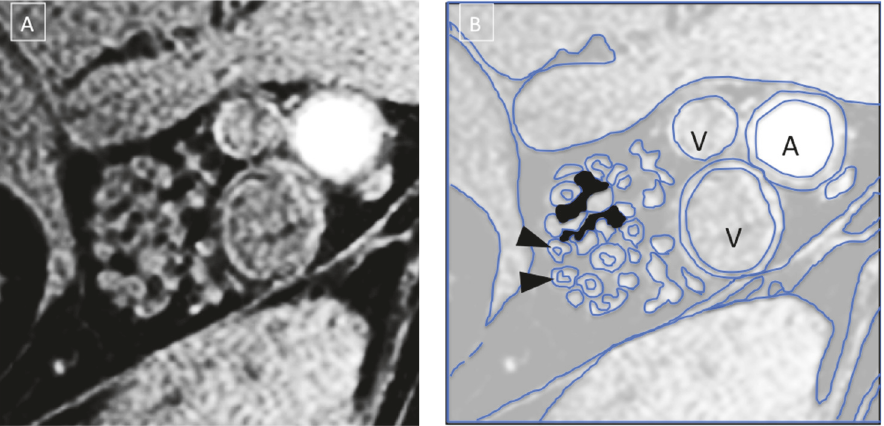
Figure 2: (A) Tibial nerve right above the level of the tibial malleolus, axial plane. Sequence: 3D SPGR IDEAL-water image. Voxel size is about 120 × 140 × 2000 𝜇 m. (B) Diagram of the internal nerve aspect that is visualized. Arrowheads: two fascicles surrounded by the perineurium. Dark areas: epineurium. A: posterior tibial artery. V: posterior tibial